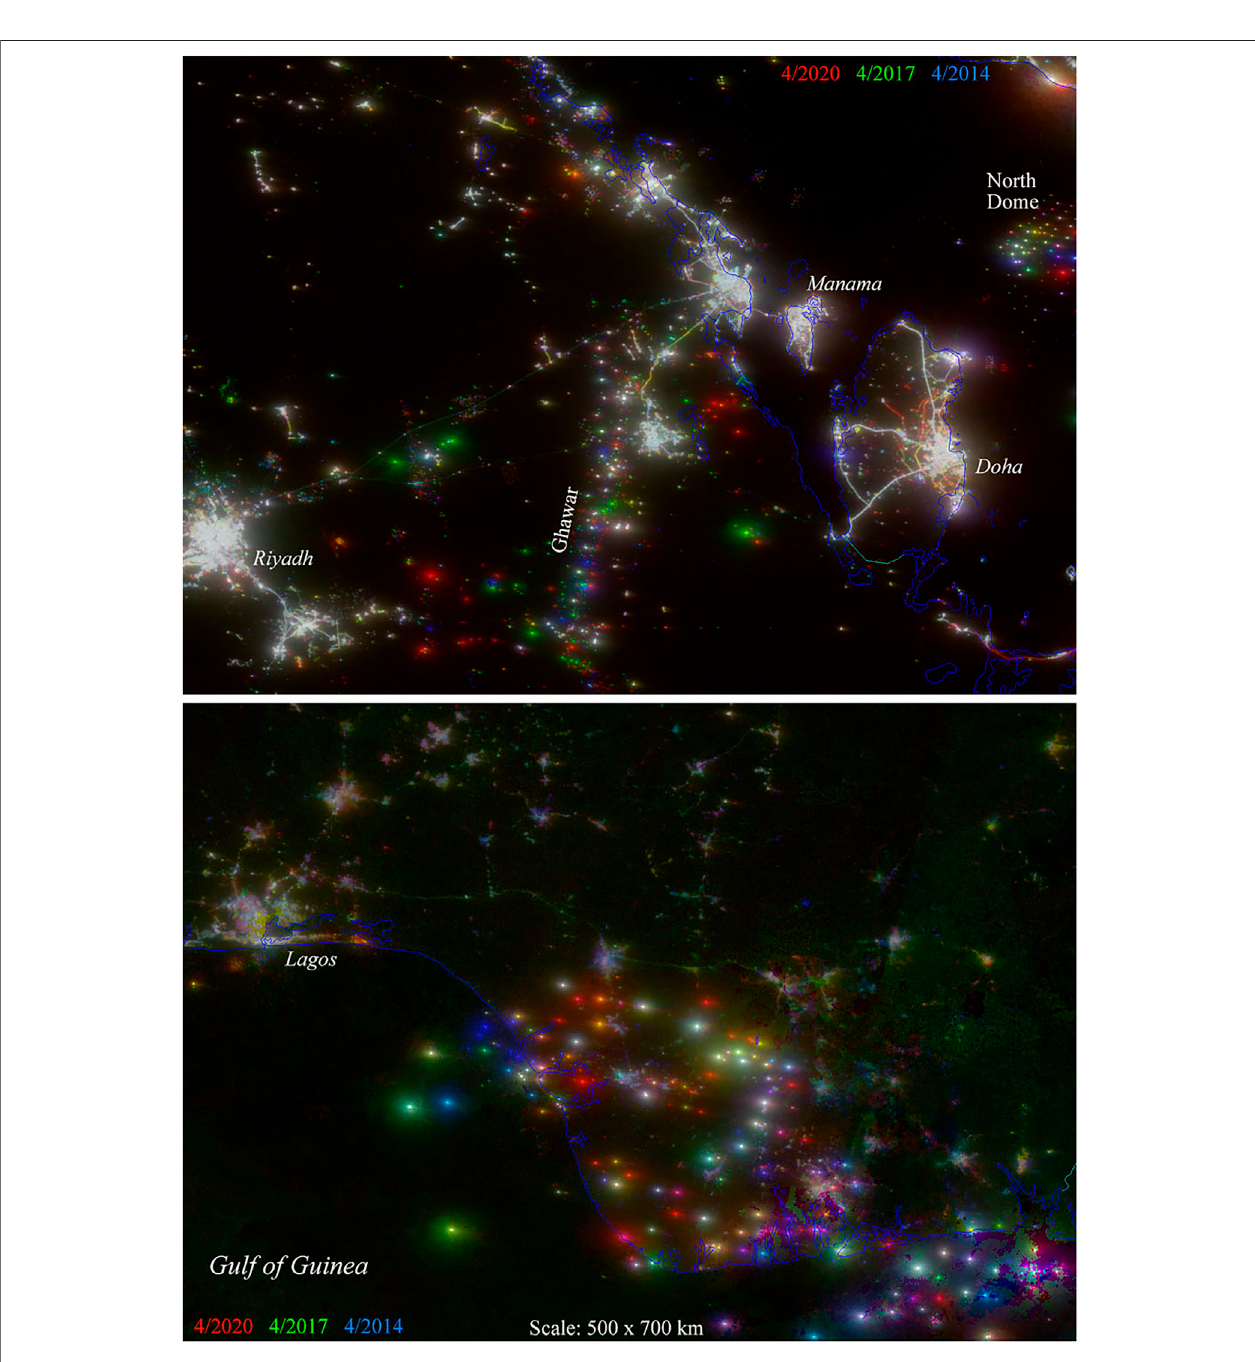
FIGURE 11 | Interannual variability of anthropogenic night light associated with oil and gas production. Stable lights appear shades of gray. Color implies change. Northwestern Arabia and the southern Gulf (top) shows pervasive change of production infrastructure lighting on both the Ghawar oil fi eld onshore and the North Dome gas fi eld offshore. The Niger Delta (bottom) shows more extensive change of both small settlements and oil production. Gas fl ares are characterized by larger, brighter sources and much larger peripheral halos.